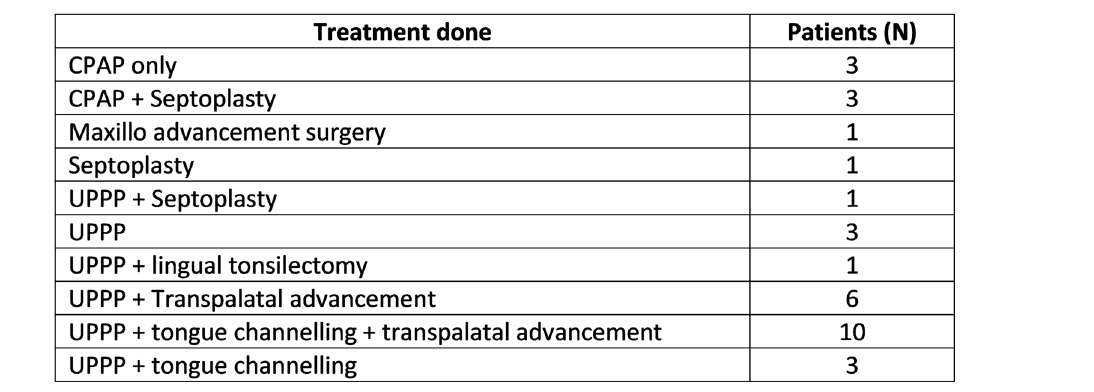
Table IV. List of treatment for each